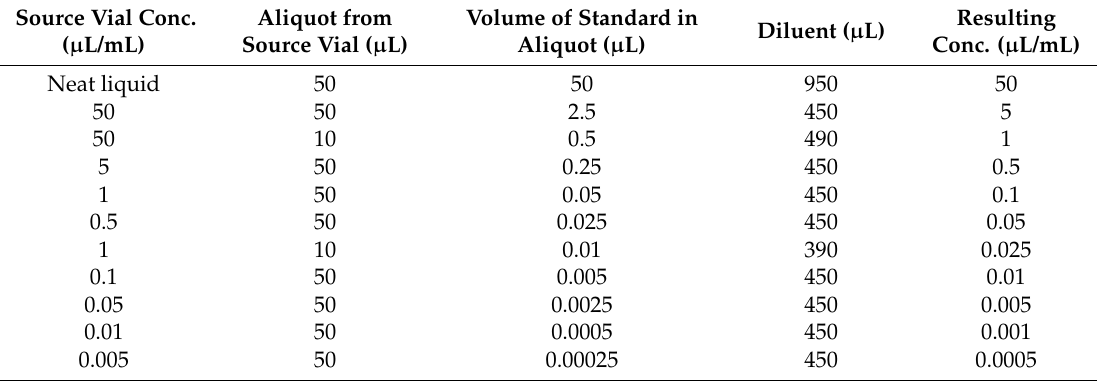
Table 1. Serial dilution scheme used to produce samples for analysis, starting from a vial containing the neat ignitable liquid. The source vial refers to the concentration of the vial being aliquoted. The aliquot from source vial column lists the volume taken for dilution. The volume of standard in aliquot column lists the resulting absolute volume of ignitable liquid contained in the aliquot. The diluent column refers to the amount of solvent or pyrolysate-doped solvent added to the aliquot, and the resulting concentration column refers to the final concentration of the sample produced in each